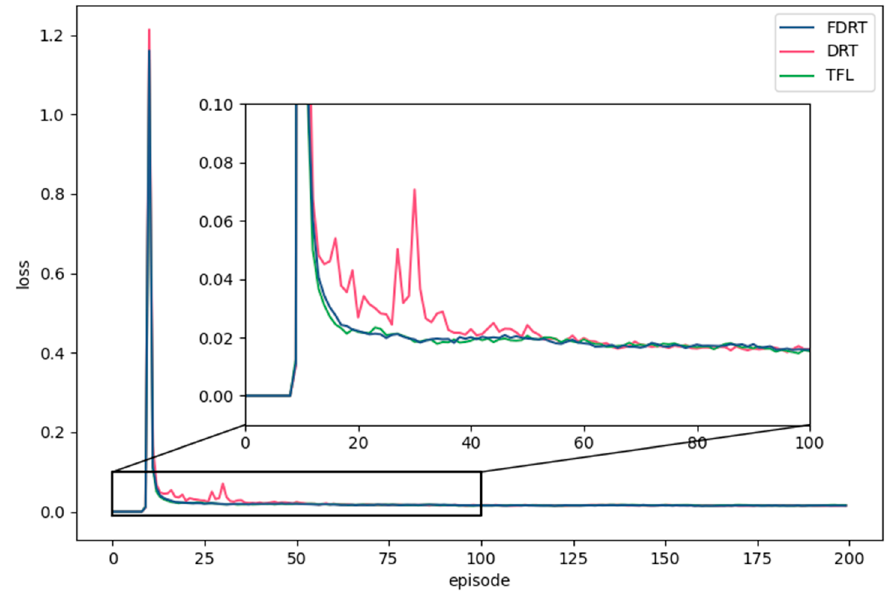
Figure 8. Comparison of losses of mobile device agents with FDRT, DRT, and TFL.